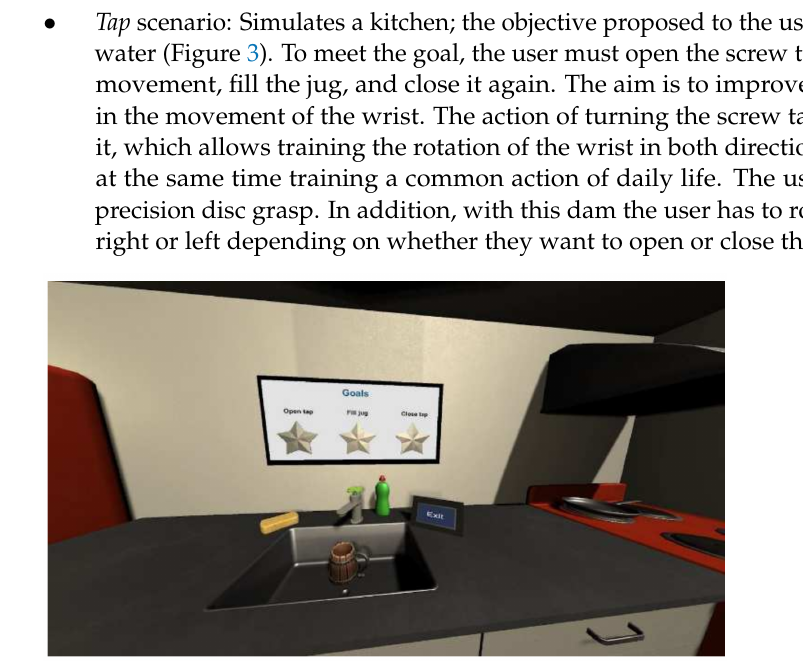
Figure 3. Tap scenario.